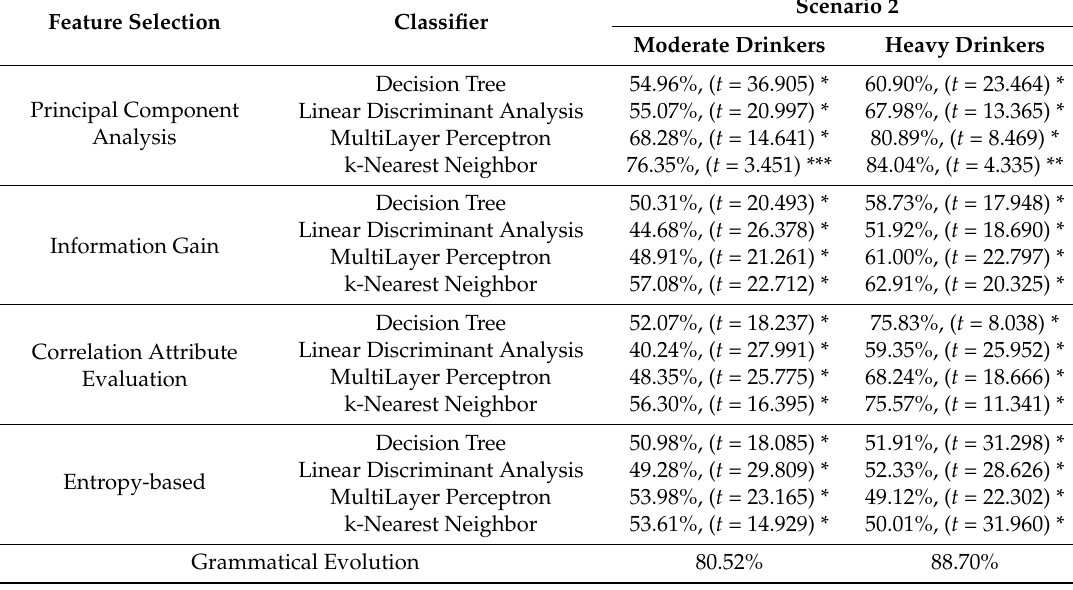
Table 3. Results in terms of accuracy for the 5 classifiers. Scenario 2 corresponds to the feature vector that contains both spectral and time-based features. In the parenthesis is reporting the statistical p -value as extracted from the Paired-sample t